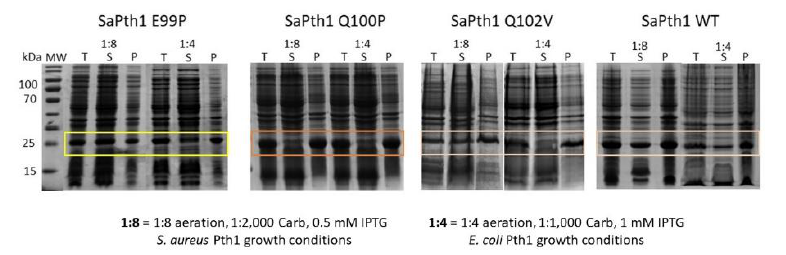
Figure 4. Gate Loop Residues Affect Pth1 Solubility. Solubility for residue changes in the Gate Loop are shown. Aeration is defined as the ratio of volume of culture media to flask volume. The total protein (T), soluble fraction (S) and insoluble pellet (P) are shown for each construct and condition.